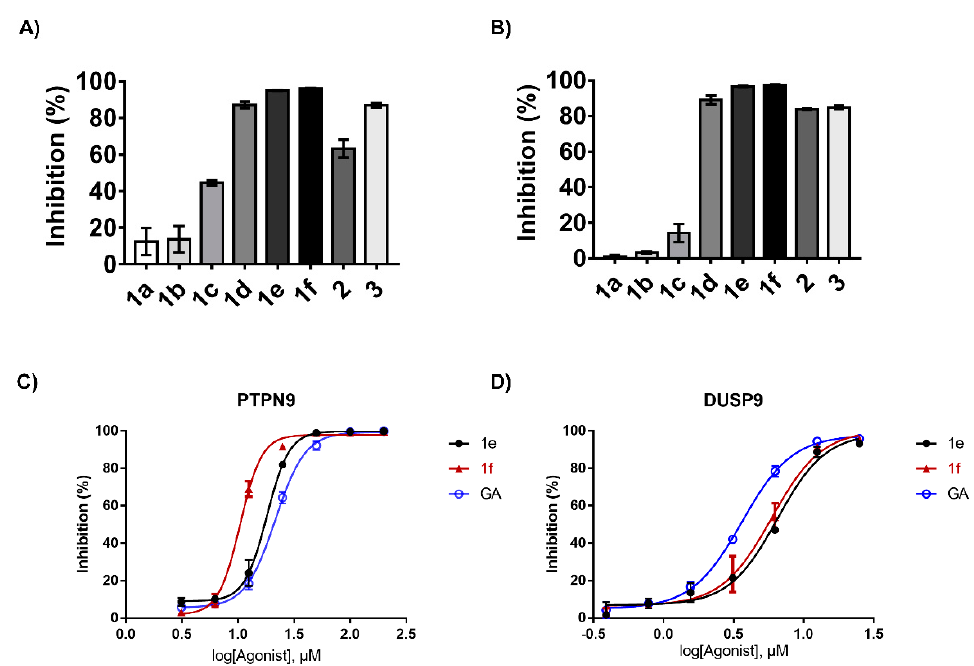
Figure 2. Inhibitory activities of GA analogs against PTPN9 ( A ) and DUSP9 ( B ). For each compound, the final enzyme concentration was 50 µM and 20 µM for PTPN9 and DUSP9, respectively. PTPN9 (0.15 nM) and DUSP9 (200 nM) were added to the mixture consisting of DiFMUP (220 µM for PTPN9 and 90 µM for DUSP9) and each compound (50 µM for PTPN9 and 20 µM for DUSP9). Enzyme activity was measured by monitoring the change in fluorescence intensity at Ex/Em = 365/450 nm. Enzyme inhibitory effects were evaluated by comparing enzyme activity in the presence of DMSO as a control, as well as each compound dissolved in DMSO. Determination of IC 50 values for 1e, 1f , and GA against PTPN9 ( C ) and DUSP9 ( D ). The inhibitor concentrations used to determine IC 50 were 200, 100, 50, 25, 12.5, 6.25, or 3.125 µM for PTPN9 and 25, 12.5, 6.25, 3.125, 1.563, 0.782, or 0.391 µM for DUSP9. Data are presented as mean ± standard deviation ( n = 2).